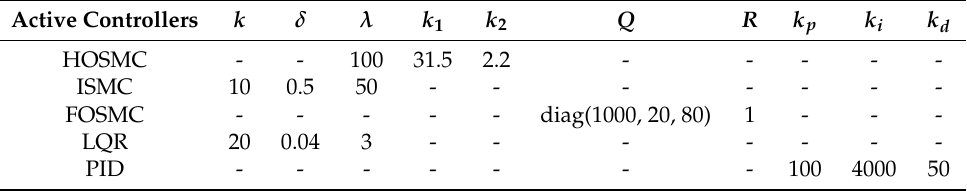
Table 2. Active controller’s